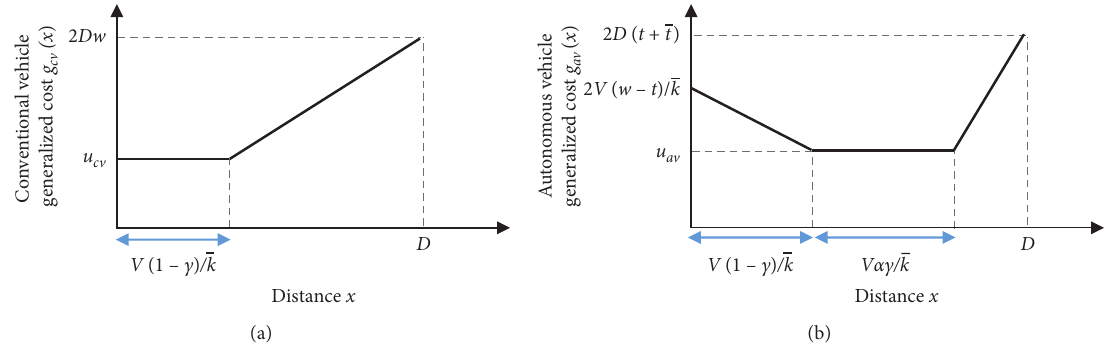
Figure 7: (a) User equilibrium for conventional vehicles, and (b) user equilibrium for autonomous vehicles.